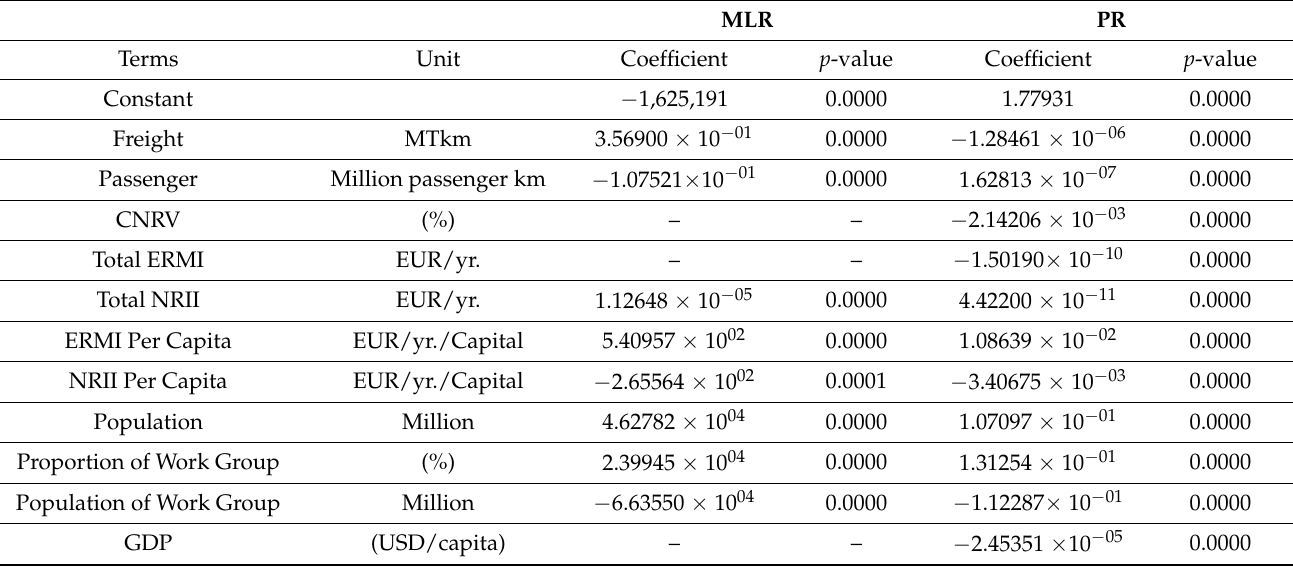
Table 2. ARA regression model